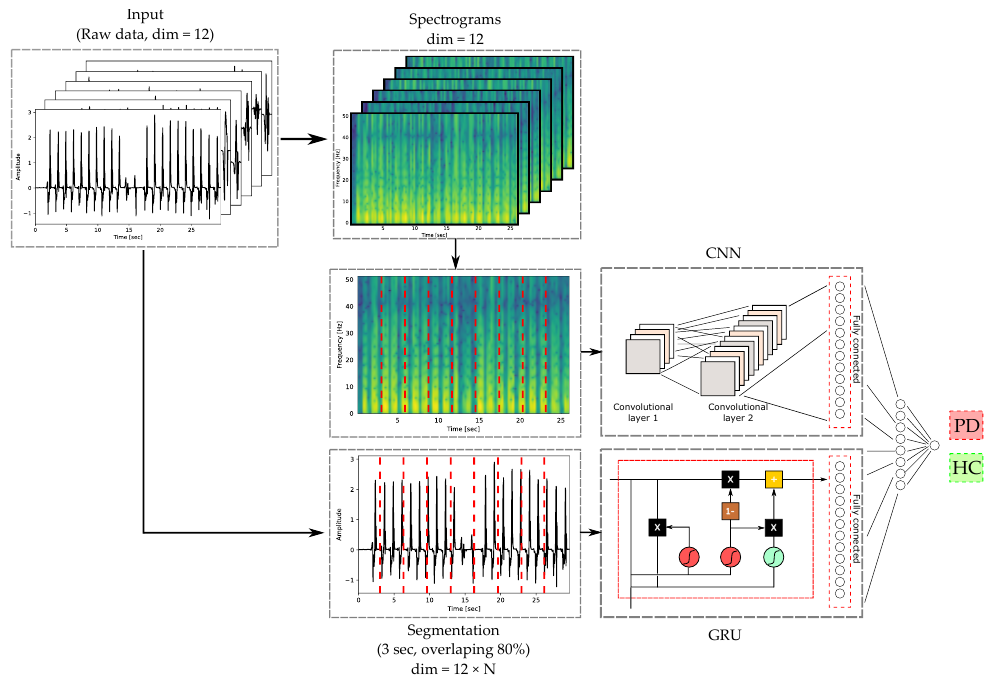
Figure 11. Proposed methodology considering a CNN + GRU architecture Table 6. Results using CNN + GRU and 2 × 10 m